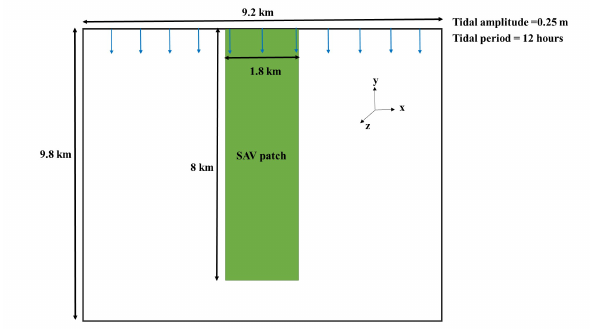
Figure 3. Planform view of the idealized test domain